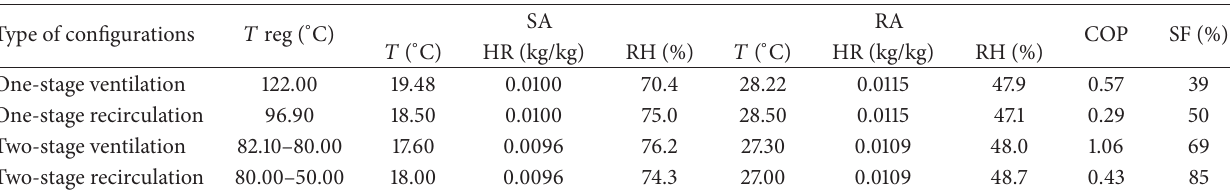
Table 7: Performance comparison of four desiccant cooling configurations under 0.005 kg/kg humidity ratio set point in hot and humid climate (30 ∘ C, 20